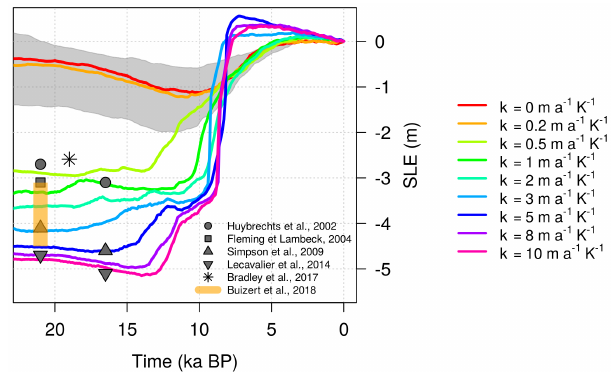
Figure 10. GrIS ice volume evolution simulated for different val- ues of the melting rate sensitivity κ during the last interglacial (see Fig. 5 for the line colour legend). The ice volumes have been con- verted to values of s.l.e. anomaly with respect to the present-day volumes estimated in each specific simulation. Grey shading rep- resents the reference basal melting rates B ref investigated for the case of constant-in-time oceanic forcing ( κ = 0ma − 1 K − 1 ). The upper bound refers to B ref = 40ma − 1 and the lower bound to B ref = 0ma − 1 . Black and white symbols indicate the LIG mini- mum ice volumes estimated by previous studies. The tight clus- tering of our estimates compared to previous work is due to the fact that the sole uncertainty is here related to the oceanic forcing through κ .